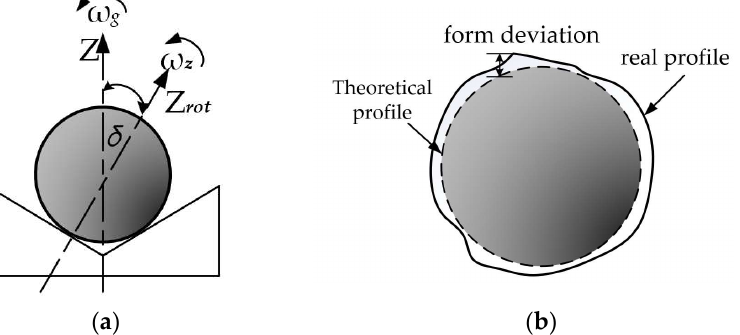
Figure 1. Ceramic ball lapping principle and spherical deviation schematic diagram. ( a ) Spherical Lapping Schematic; ( b ) Diagram of spherical deviation.